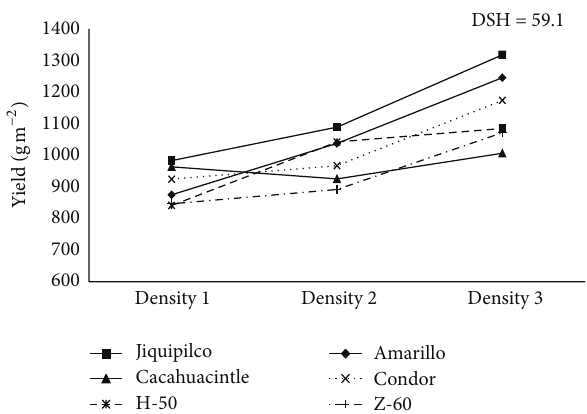
Figure 2: Interaction yield versus plant density evaluated at 2008, 2009, and 2010 summer. El Cerrillo, Toluca Mexico. Densities 1, 2, and 3 = 6.9, 7.8, and 8.9 plants m −2 ,